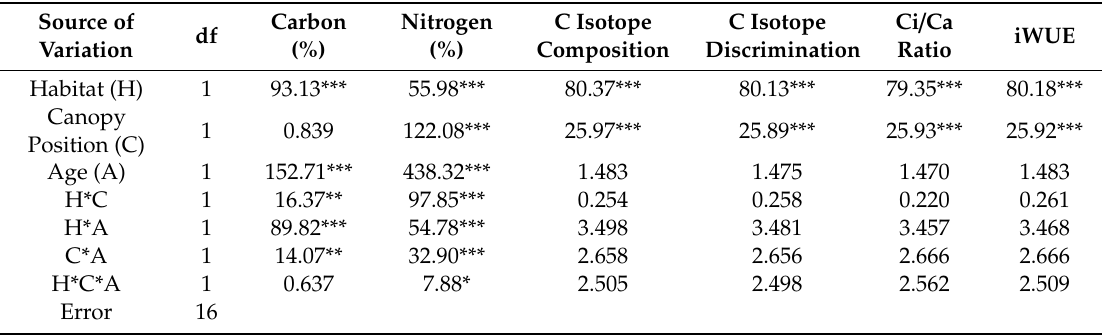
Table 1. Results of two-way ANOVA (F-values) testing the e ff ects of habitat type, canopy position, and leaf age on carbon (%), nitrogen (%), carbon isotope discrimination, and intrinsic water-use e ffi ciency (iWUE) attributes of Prosopis juliflora.